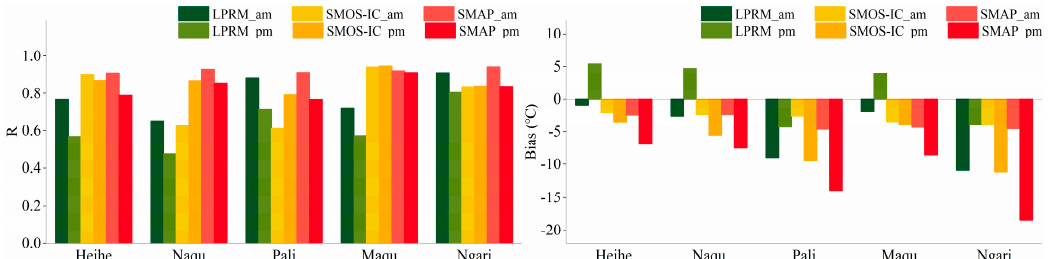
Figure 10. The comparison of three performance metrics (including R and Bias) for the LPRM, SMOS-IC, and SMAP Ts data products for the morning (nighttime) and afternoon (daytime) orbits from 2012 to 2016 in five in situ networks.